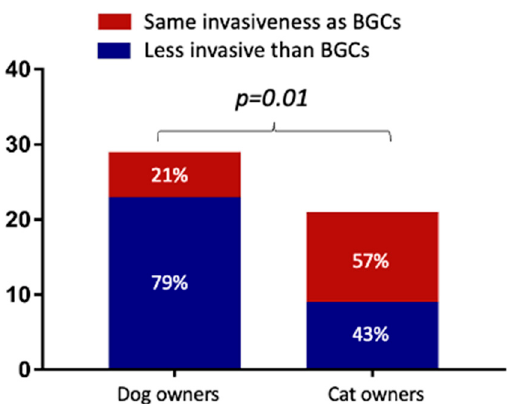
Figure 1. Comparison of dog and cat owners’ points of view regarding the invasiveness of the flash glucose monitoring system (FGMS) when compared to blood glucose curves (BGCs).